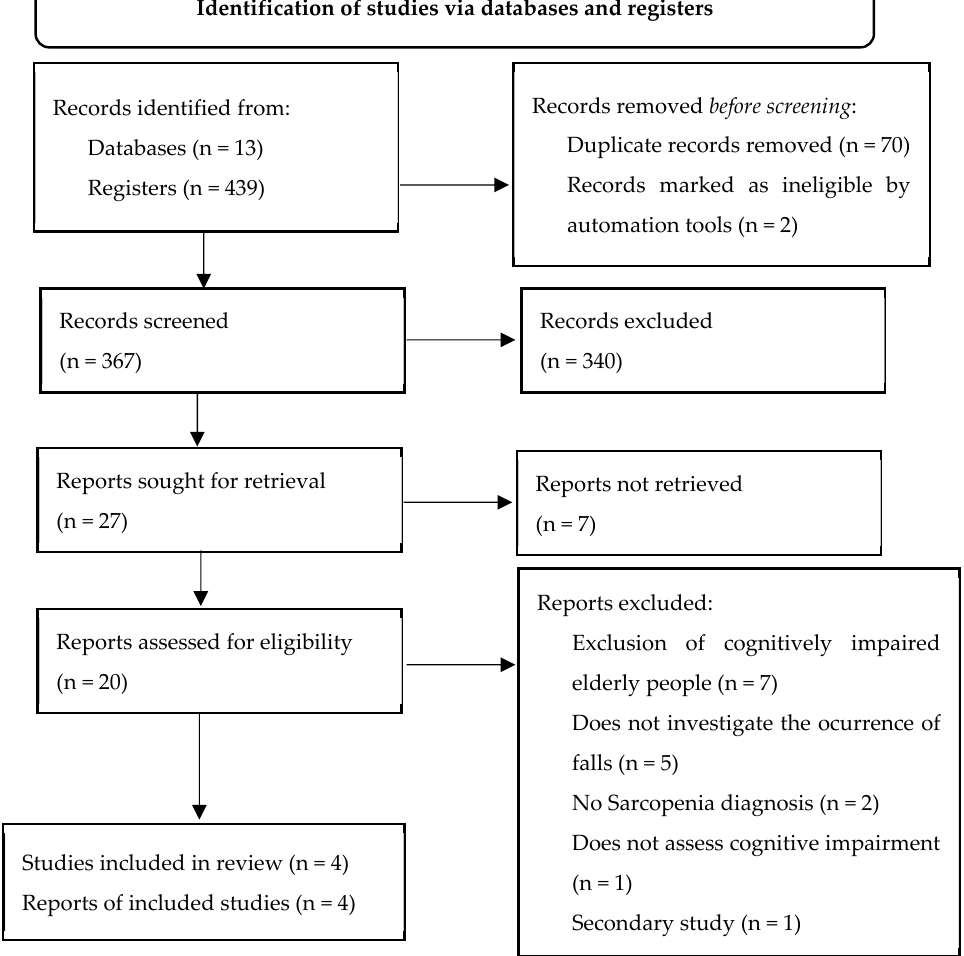
Figure 1. PRISMA Flowchart of study identification and selection. S ã o Paulo, SP, Brazil,